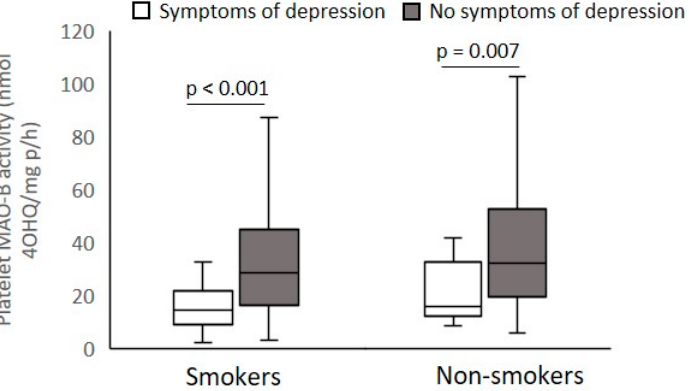
Figure 6. Platelet MAO-B activity in subjects with severe and mild symptoms evaluated by the PANSS-depressed subscale, subdivided according to smoking status.